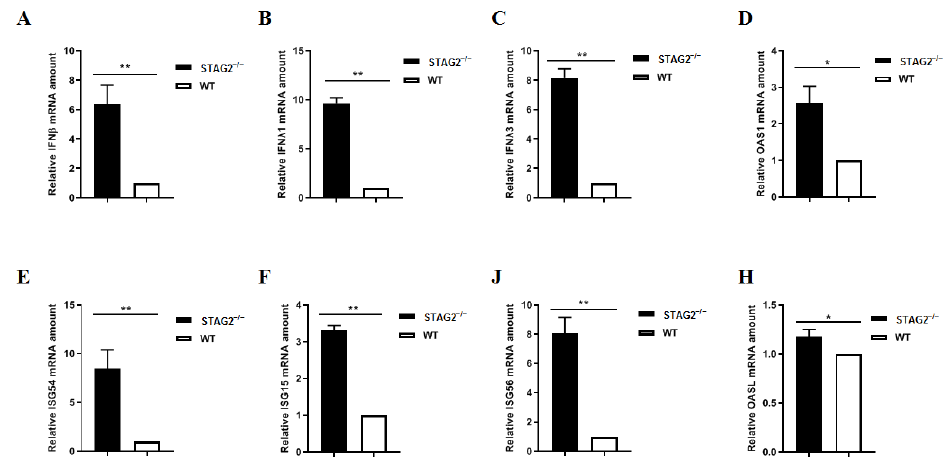
Figure 5. Loss of STAG2 triggers excessive IFN production. ( A – H ) The mRNA levels of antiviral genes, IFN- β , IFN- λ 1, IFN- λ 3, OAS1, IL-54, IL-15, IL-56, and OASL, were examined by quantitative RT-PCR. The results are representative of three independent experiments (the means ± SD). * p < 0.05, **, p < 0.01. The p value was calculated using Student’s t -tests.